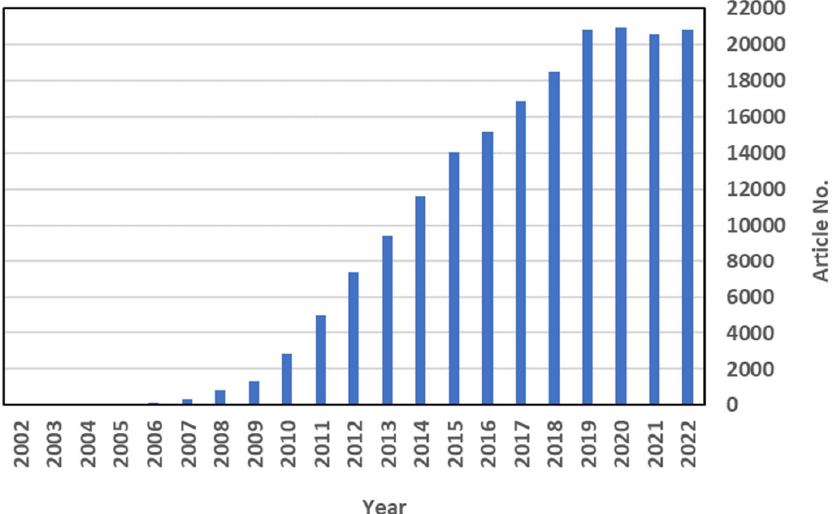
Figure 1. Number of articles (Article No.) regarding graphene from the year 2002 to 2022 docu ‐ mented in the Scopus database (keywords: “graphene”) on 28 December